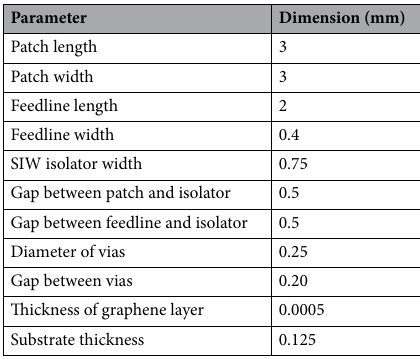
Table 1. Dimensions of the antenna.